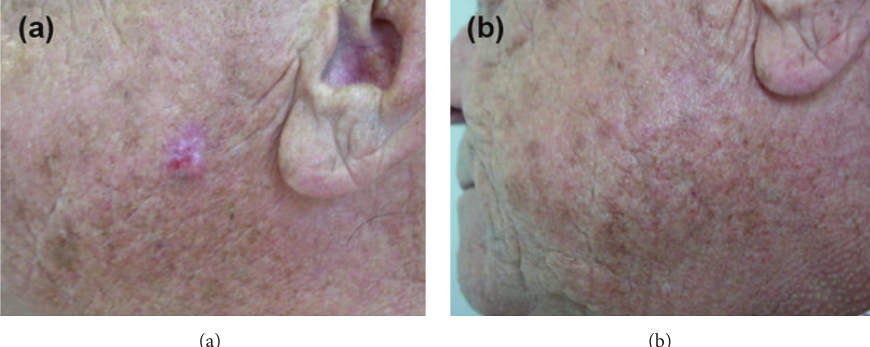
Figure 2: Patient 4. (a) A facial basal cell carcinoma appeared after six months of everolimus treatment. (b) The lesion had disappeared after a further nine months of treatment (3mg